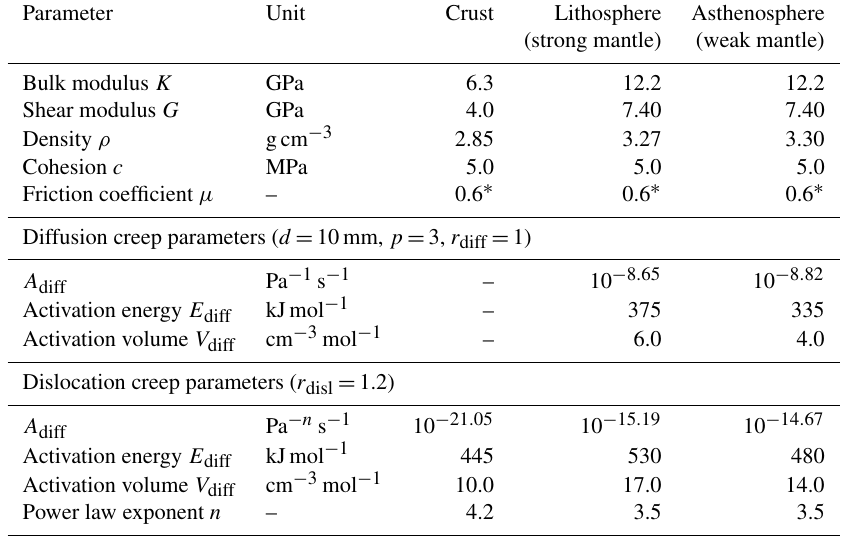
Table A1. The upper mantle creep viscosity is calculated using olivine parameters from the axial compression experiments of Hirth and Kohlstedt (2004). Crustal rheology is taken from (Wilks, 1990). The rheological parameters used in this study with varying olivine water content of 100, 500, 1000ppm H/10 6 Si in the weak asthenospheric mantle with dry lithosphere material. For more details regarding the formulation of the physical model and numerical implementation the reader is referred to Popov and Sobolev